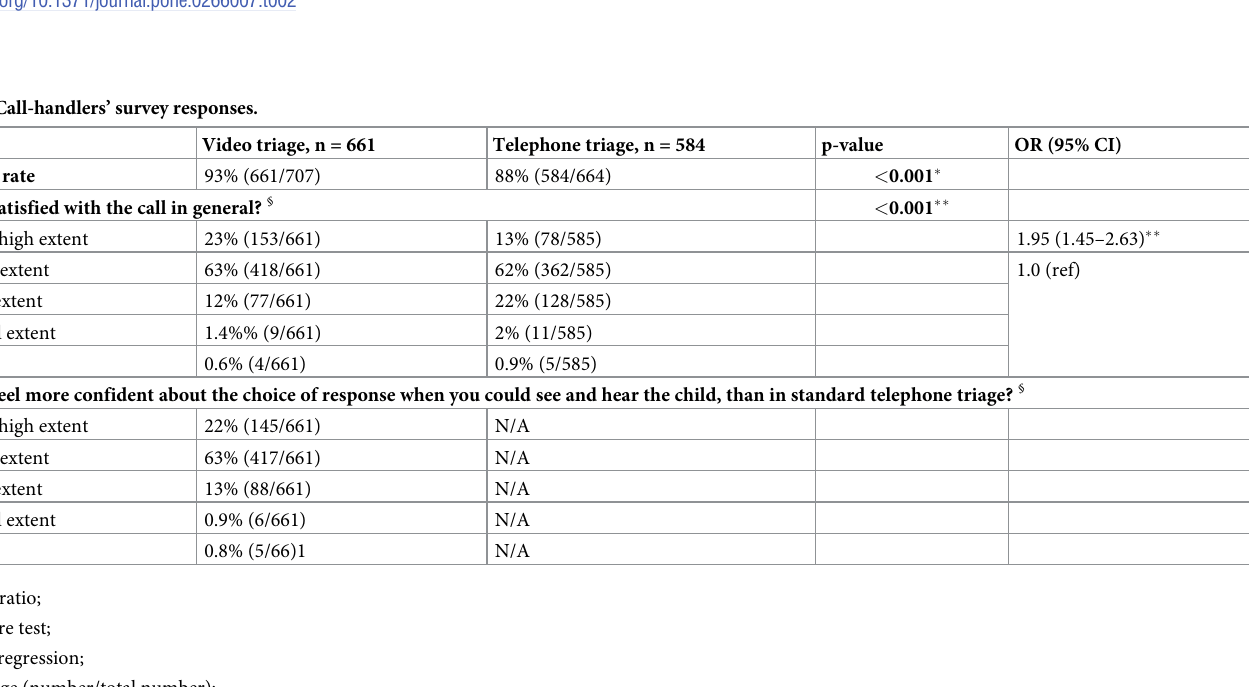
Table 3. Call-handlers’ survey